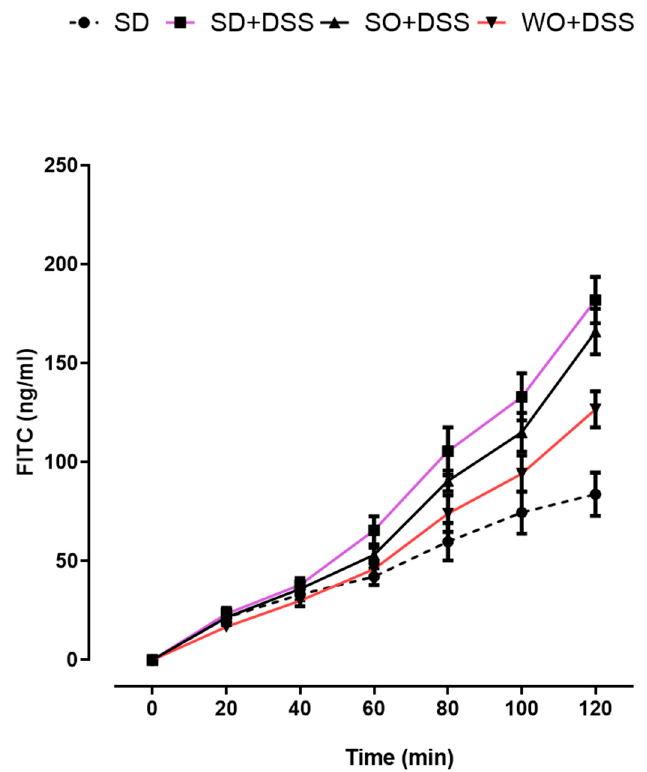
Figure 6. Effect of diet enriched with sunflower oil (SO) and walnut oil (WO) on colon permeability in DSS-treated mice. Data represent mean ± SEM, n = 8 animals per group. SD and SD + DSS groups are significantly different starting from 80 min (80 min, p < 0.001; 100 min, p < 0.001; 120 min, p < 0.001). SD + DSS and WO + DSS groups are significantly different starting from 80 min (80 min, p < 0.05; 100 min, p < 0.01; 120 min, p < 0.001).